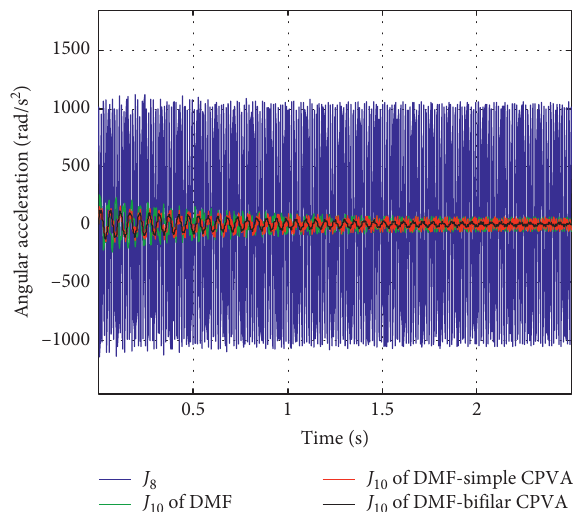
Figure 11: Angular acceleration curves of J of engine